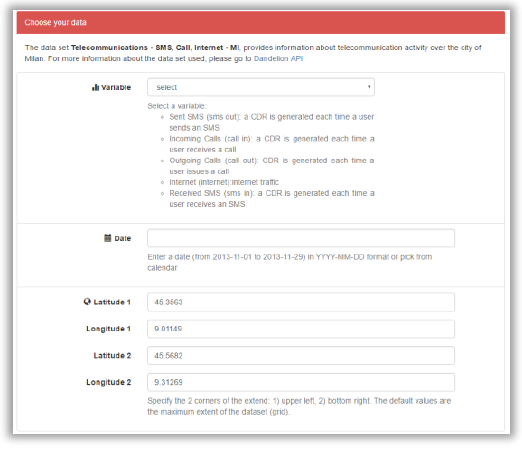
Figure 4. WCPS query first panel